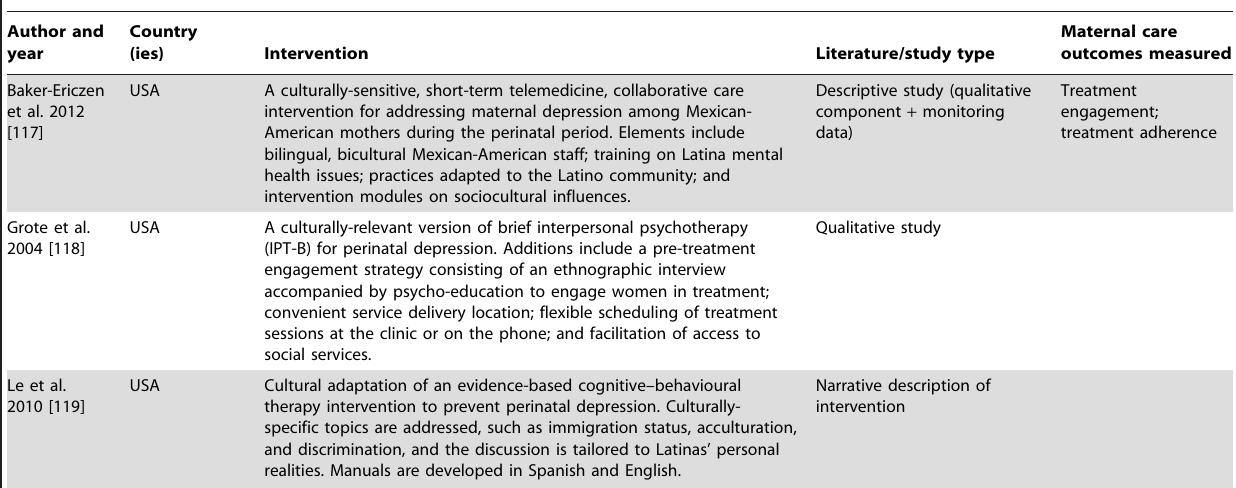
Table 7. Included items: Mental health